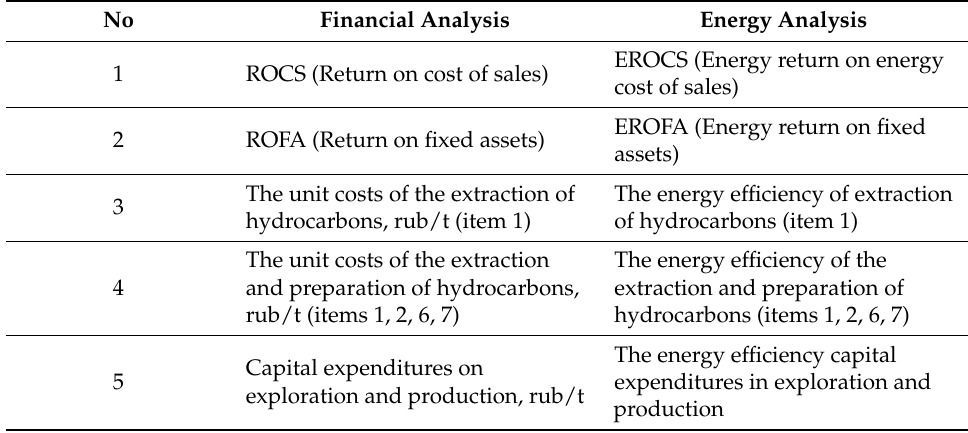
Table 3. Financial and energy indicators of